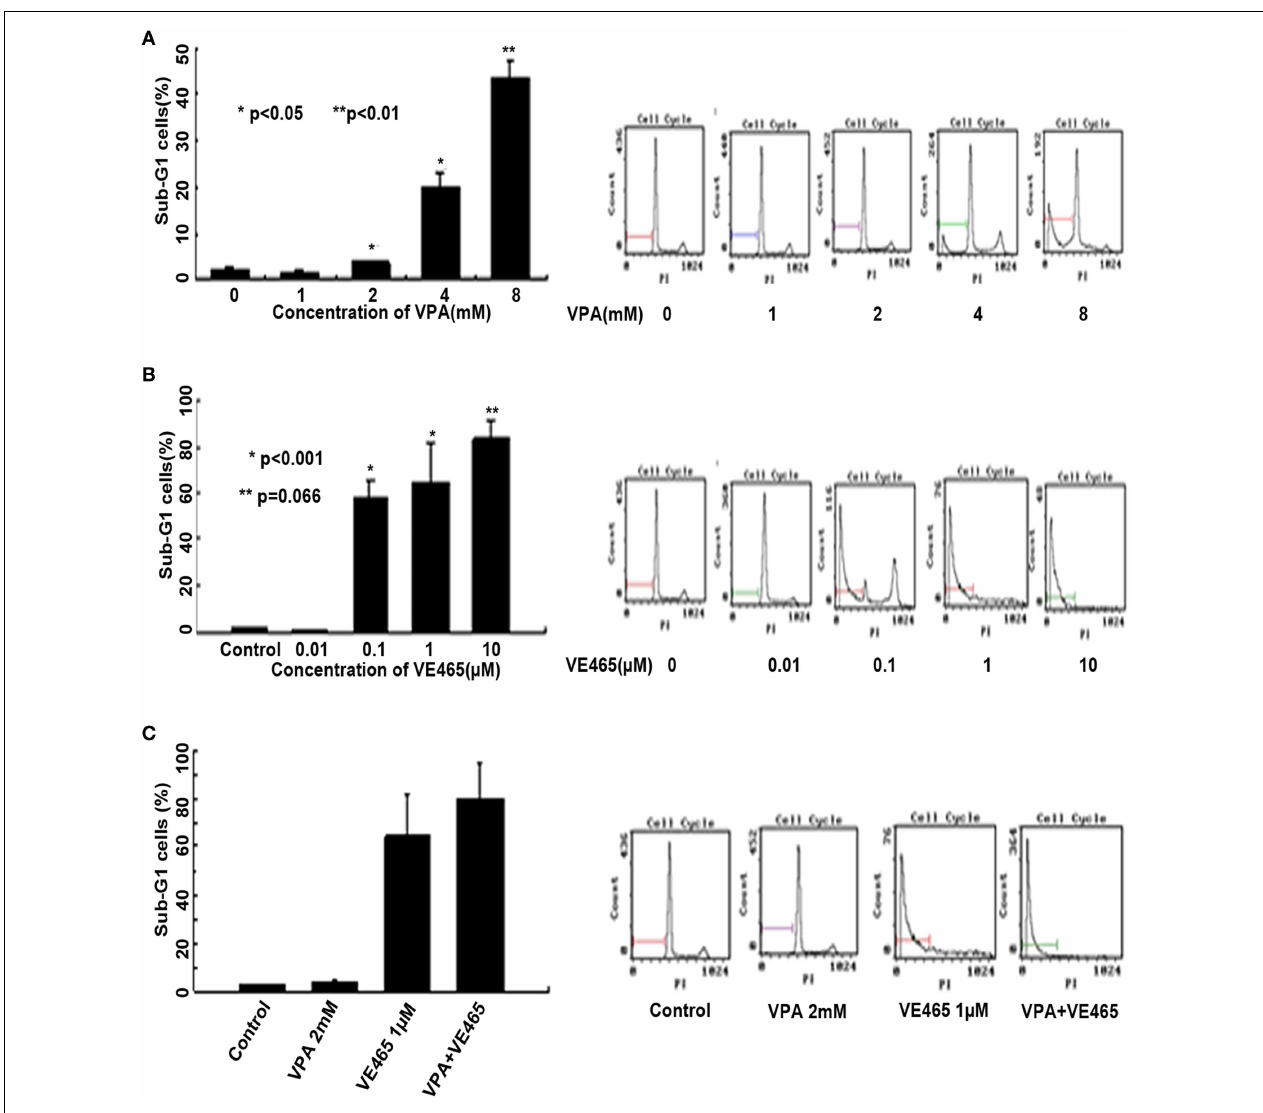
FIGURE 4 | Flow cytometric analysis of 2008/C13 cells after 72h of treatment withVPA orVE465, alone and in combination. (A) Treatment withVPA alone with increasing concentrations (1–8mM). (B) Treatment withVE465 alone at increasing concentrations (0.01–10 µ M). (C) Co-treatment withVPA (2mM) andVE465 (1 µ